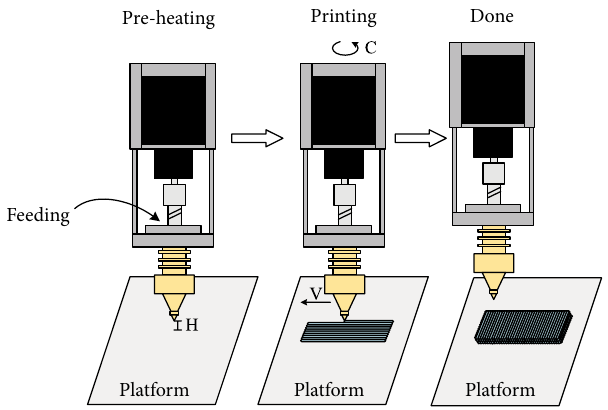
Figure 3: The main process of printing: after feeding, PCL pellets were pre-heated and then printed layer by layer, as the product.